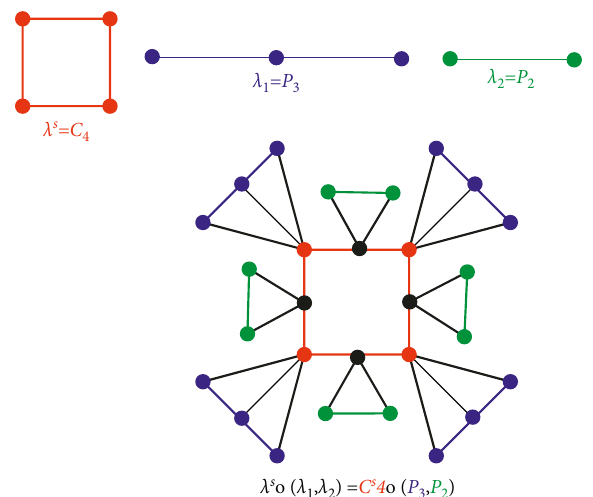
Figure 1: Subdivision double corona product ( C s